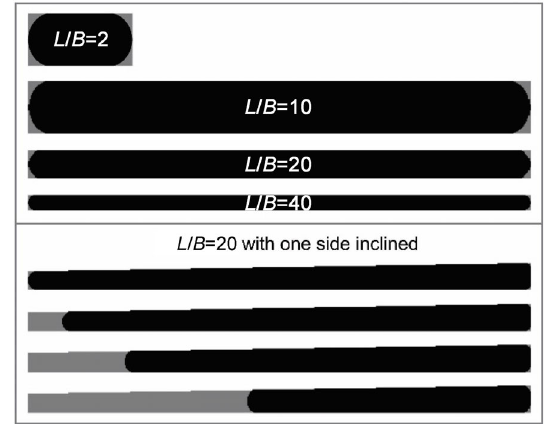
Fig. 11 Detachment of flat-ended stamps with rectangular cross- sections having various aspect ratios L/B . We show only the final stable states. Independently from the aspect ratio, the final state corresponds to almost complete rectangle with rounded-up corners. When the shape has an inclination, a continuous detachment becomes